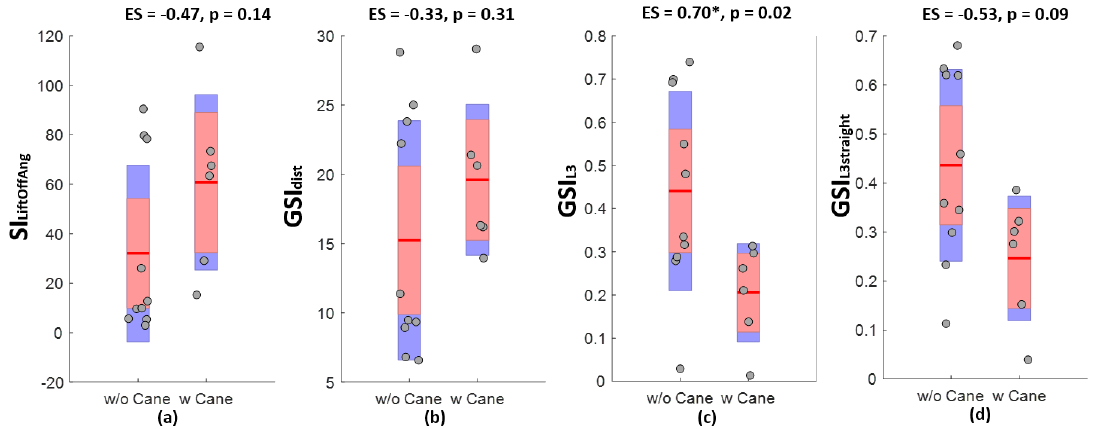
Figure 3. Boxplots of various gait symmetry indices measured in post-stroke patients with (w Cane) or without (w/o Cane) using cane. Effect size (ES) is measured with Cliff’s Delta and p value is determined by Wilcoxon rank sum test. * indicates p < 0.05. ( a ) Comparison and effect size of SI LiftOffAng . ( b ) Comparison and effect size of GSI dist . ( c ) Comparison and effect size of GSI L3 . ( d ) Comparison and effect size of GSI L3straight .